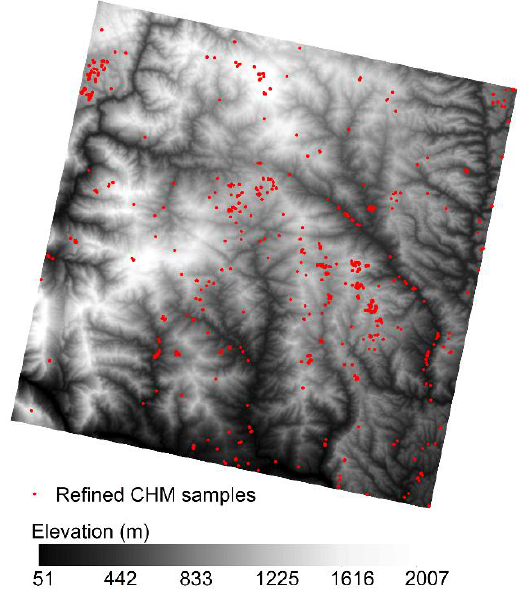
Figure 8. Refined CHM samples on the elevation layer.